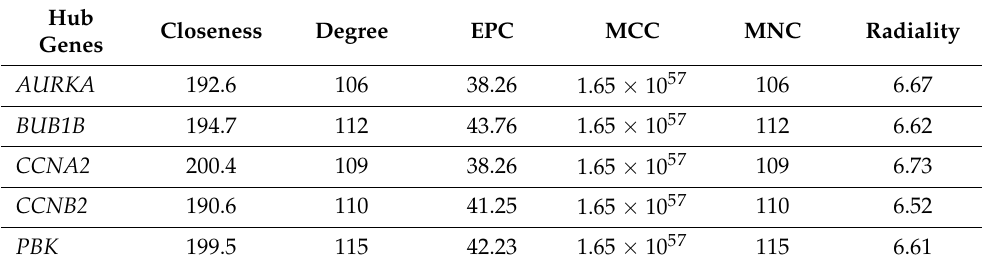
Table 1. The values of hub genes for various topological algorithms of cytohubba.